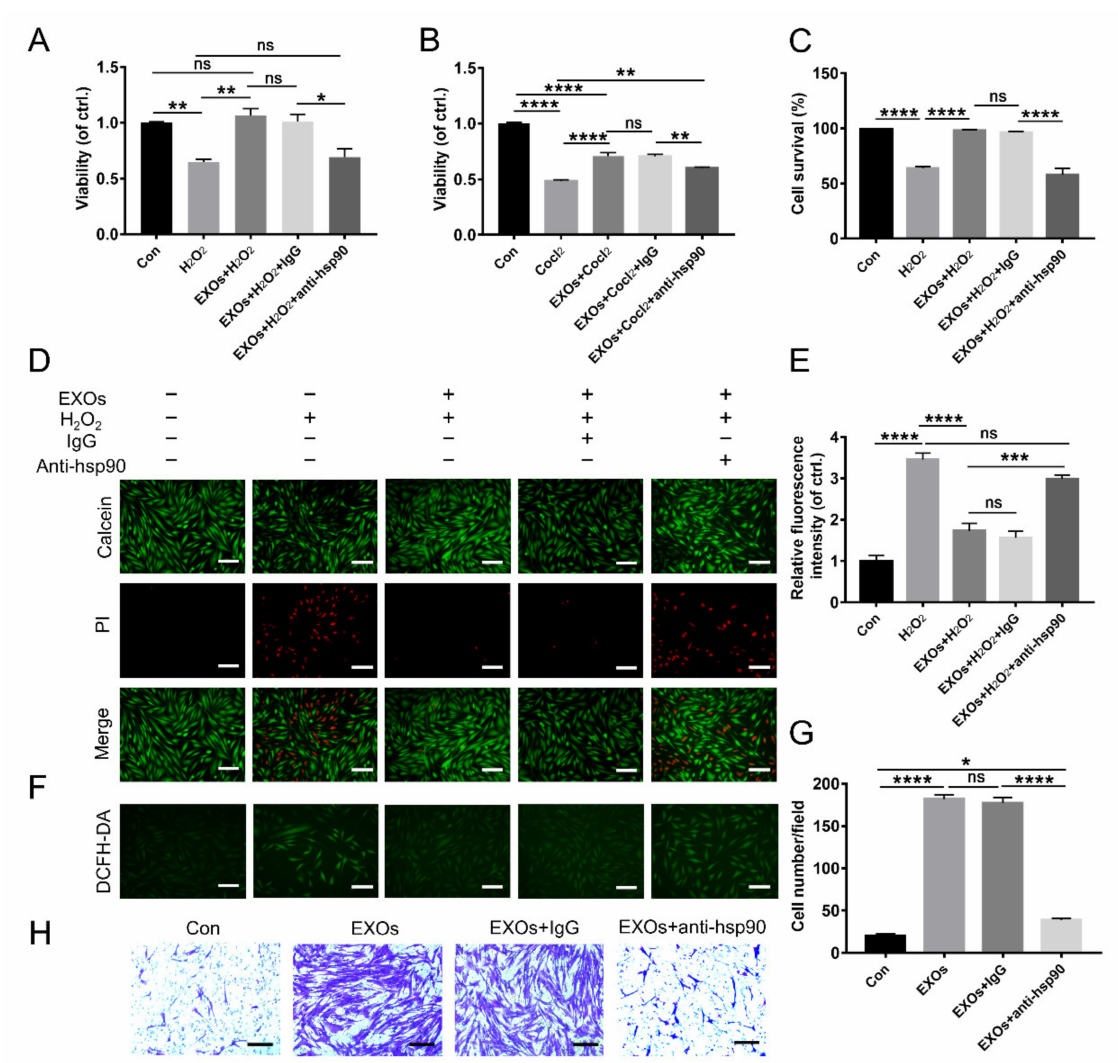
Figure 3. An anti-HSP90 antibody antagonized the beneficial effect of ADSC-EXOs. ADSC-EXOs were pre-incubated with PBS, IgG, and an anti-HSP90 antibody for 30 min at 37 ◦ C and then used in the following assays. ( A ) CCK8 analysis of the cell viability of fibroblasts under H 2 O 2 exposure in each group. ( B ) CCK8 analysis of the cell viability of fibroblasts under CoCl 2 exposure in each group. ( C ) Quantitative analysis of the data in ( D ). ( D ) Evaluation of the cell viability by Calcein-AM/PI staining; the green color represents survival cells, and the red color represents dead cells. ( E ) Quan- titative analysis of the relative fluorescence intensity in ( F ). ( F ) Representative DCFH fluorescent images of fibroblasts in each group. ( G ) Quantitative analysis of the data in ( H ). ( H ) Representative micrographs of migratory fibroblasts in each group. n = 5. Scale bar: 100 µ m. ns p >0.05, * p < 0.05, ** p < 0.01, *** p < 0.001, **** p <